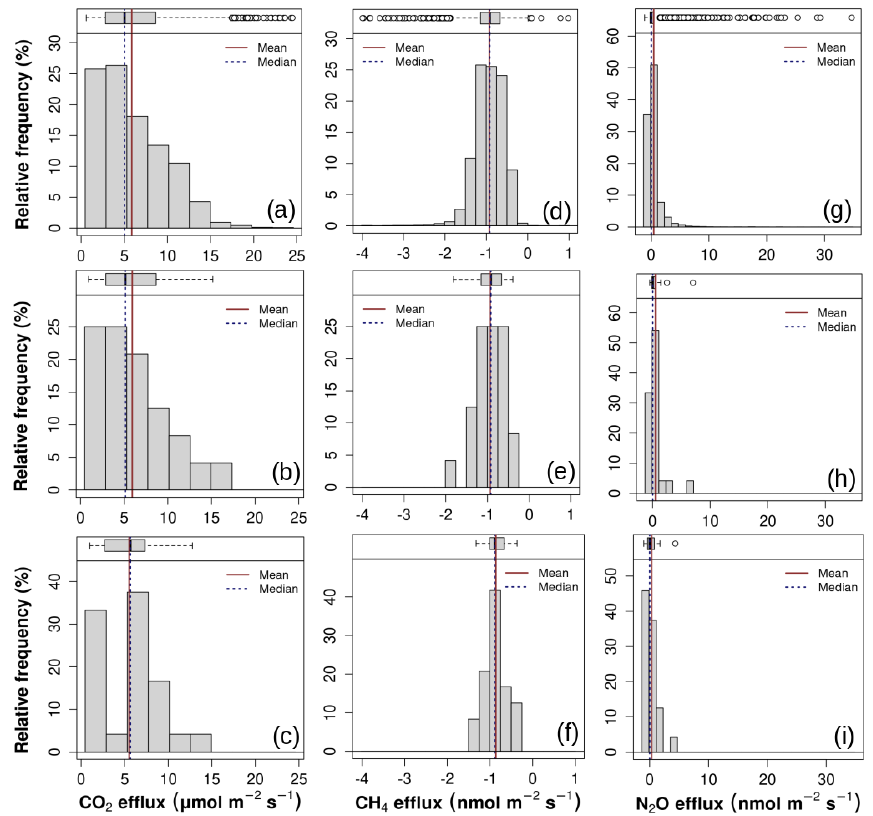
Figure 3. Histograms for automated measurements of soil CO 2 ( F A CO 2 ; a ), soil CH 4 ( F A CH 4 ; d ), and soil N 2 O ( F A N 2 O; g ). Histograms for optimized samples ( k = 24) using a temporal univariate Latin hypercube sampling (tuLHs) approach for soil CO 2 (b) , soil CH 4 (e) , and soil N 2 O (h) fluxes. Histograms for fixed temporal stratification (i.e., stratified manual sampling schedule) ( k = 24) for soil CO 2 (c) ,